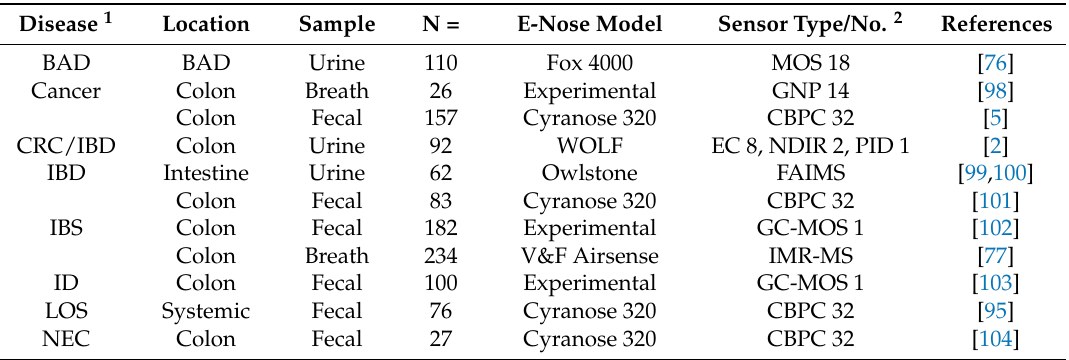
Table 4. Recent applications of electronic-nose technologies for the noninvasive early diagnosis of gastrointestinal